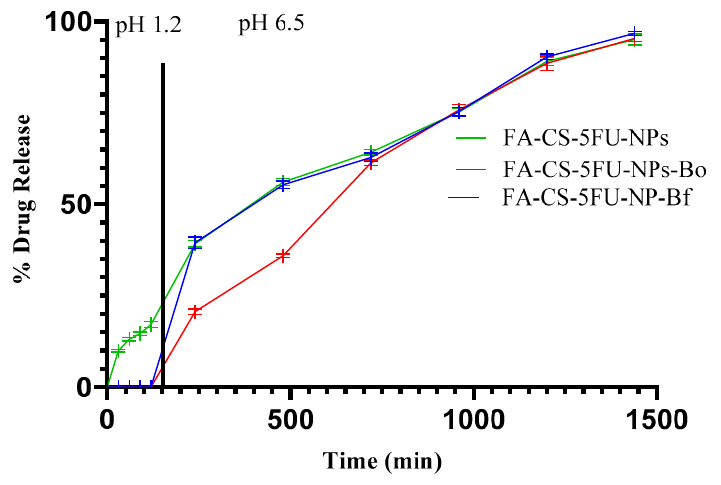
Figure 7. In vitro drug release study of FA-CS-5FU-NPs and FA-CS-5FU-NP-Bf and FA-CS-5FU- NP-Bo.